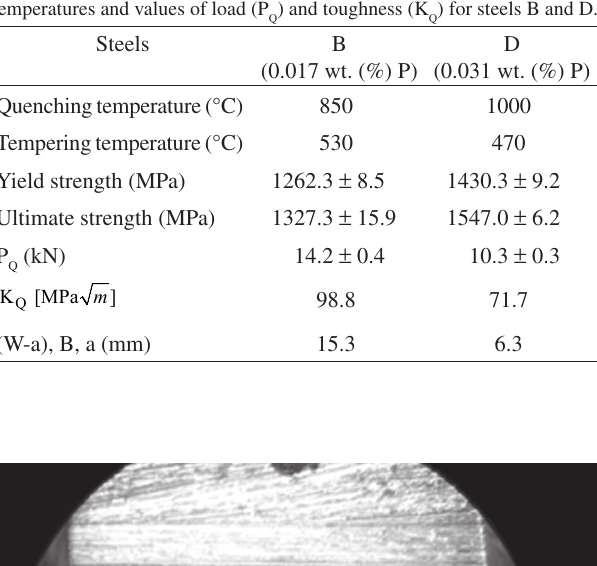
Table 3. Mechanical properties from tensile test, austenitizing and tempering temperatures and values of load (P